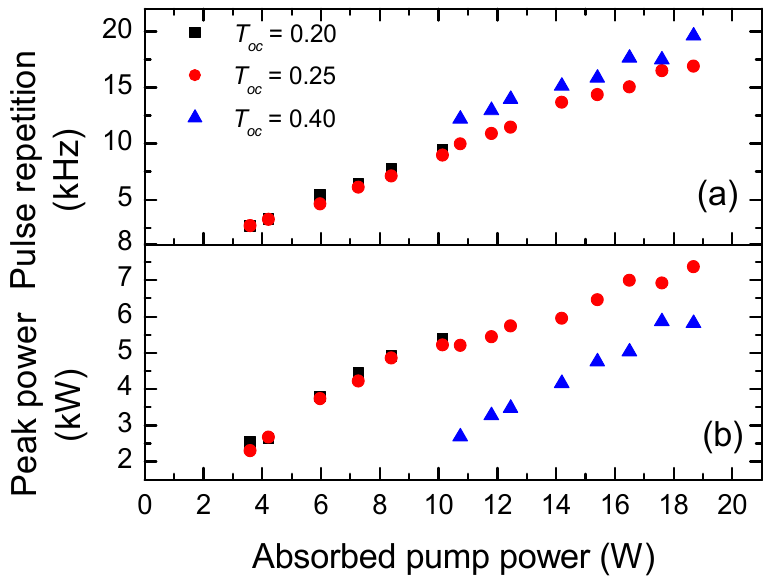
Figure 4. ( a ) Pulse repetition rate and ( b ) peak power vs. absorbed pump power. The energy and duration of PQS lasers, and then peak power, are relative to some parameters determined by the geometry of resonator and the pump laser intensity. To improve the pulse peak power, we increase the pump laser-mode radius focused into the gain crystal to ~600 µ m by replacing the focus lens F1 with the other lens with a focus length of 75 mm for the laser with the 0.25 transmittance of OC. These experimental results were shown in Figure 5, Figure 6. For comparison, the results from the laser with ~400 µ m pump mode radius were simultaneously plotted in the figures. The output power and slope efficiency declined slightly due to the slight mode-mismatch between laser-mode and pump-mode (shown in Figure